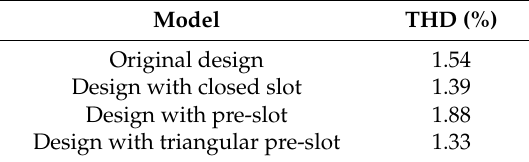
Figure 9. Harmonic spectrum for the proposed reduction method.